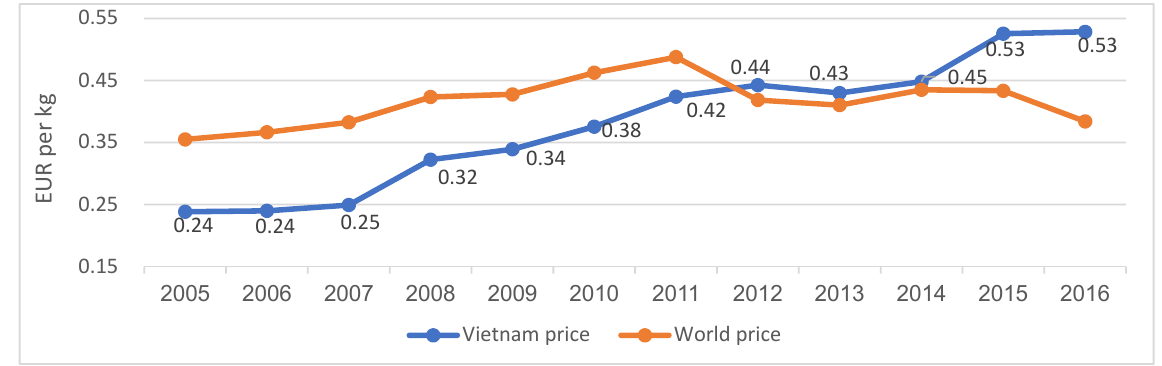
Figure 6. Vietnam’s farm-gate price (nominal terms) of raw milk and world prices (EUR per kg). Source: Authors’ analysis based on FAO [56].